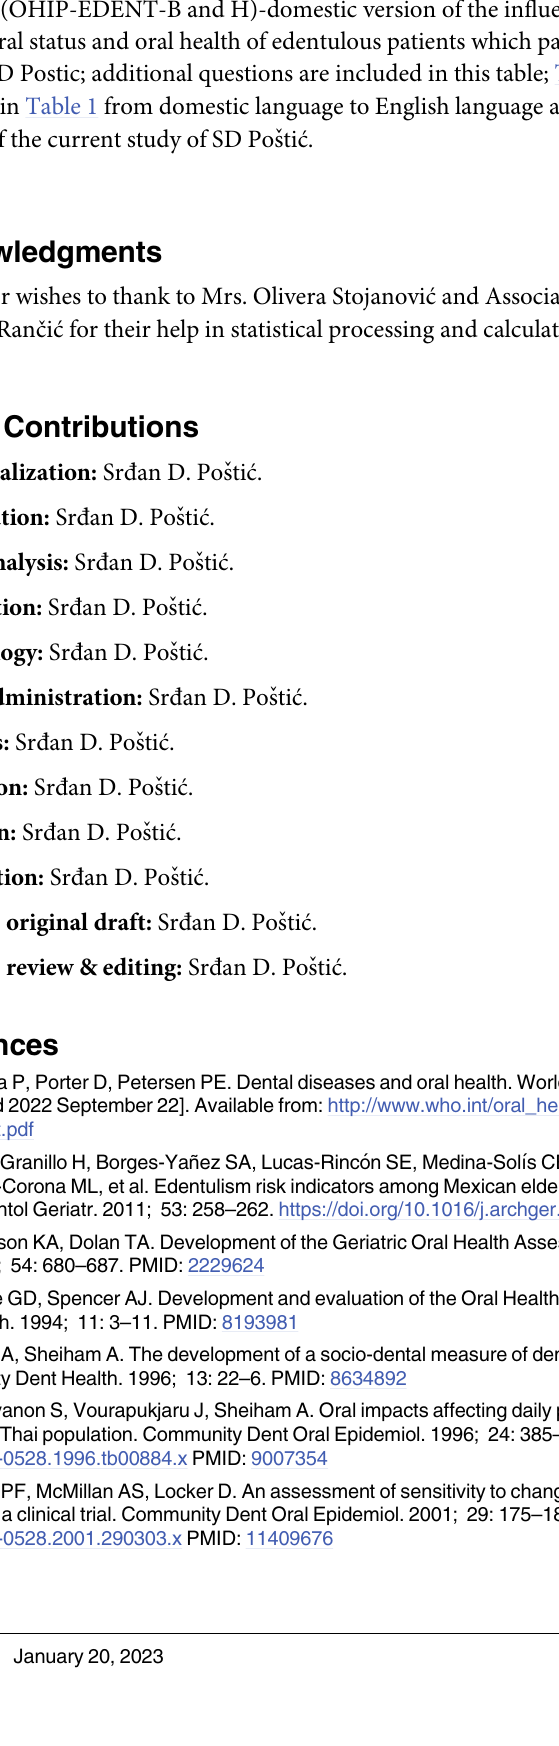
Table 1A. (OHIP-EDENT-B and H)-domestic version of the influence of the specific compo- nents to oral status and oral health of edentulous patients which participated in the current study of SD Postic; additional questions are included in this table; Table 1B–Translations of questions in Table 1 from domestic language to English language and extension added for the purpose of the current study of SD Posˇti ć